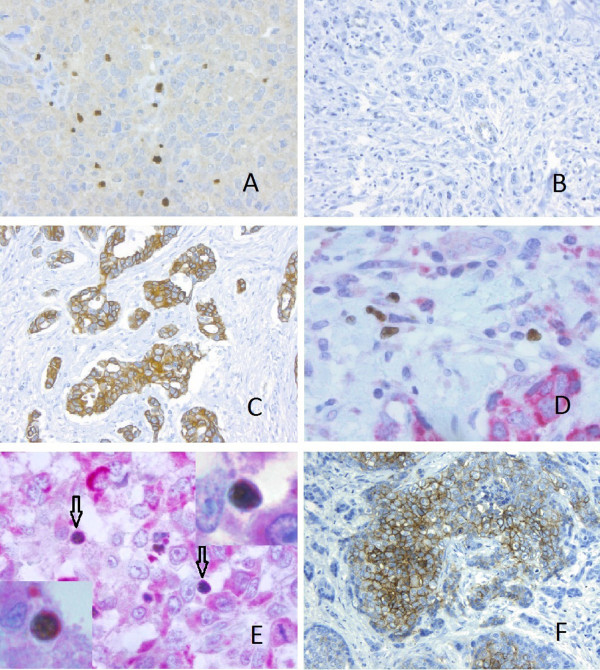
Immunohistochemistry for FOXP3, CXCL12, CXCR4 and CA9. Immunohistochemical staining for (A) FOXP3 positive tumour infiltrating Treg (x20), (B) Tumour cells negative for CXCL12 (x10), (C) Tumour cells showing strong positivity for CXCL12 (x10). (D, E) Double immunohistochemical staining for FOXP3 (brown, nuclear) and CXCR4 (red, cytoplasmic). (D) CXCR4 negative Treg (x40), (E) CXCR4 positive Treg (arrows) (x40), Inset (x100 oil immersion), (F) Tumour cells with positive CA9 staining.